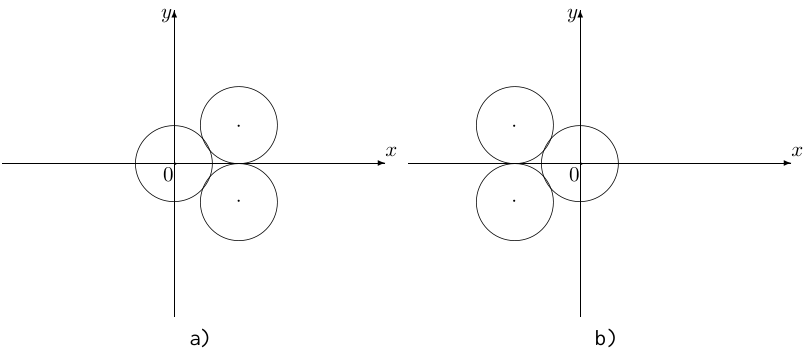
Figure 6. Special packages: a) package of three discs I, b) package of three discs